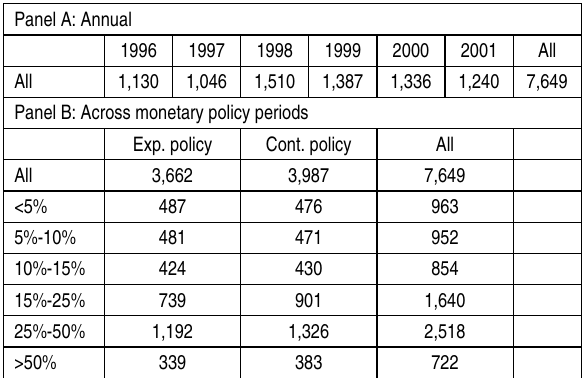
Table 2. Sample firms